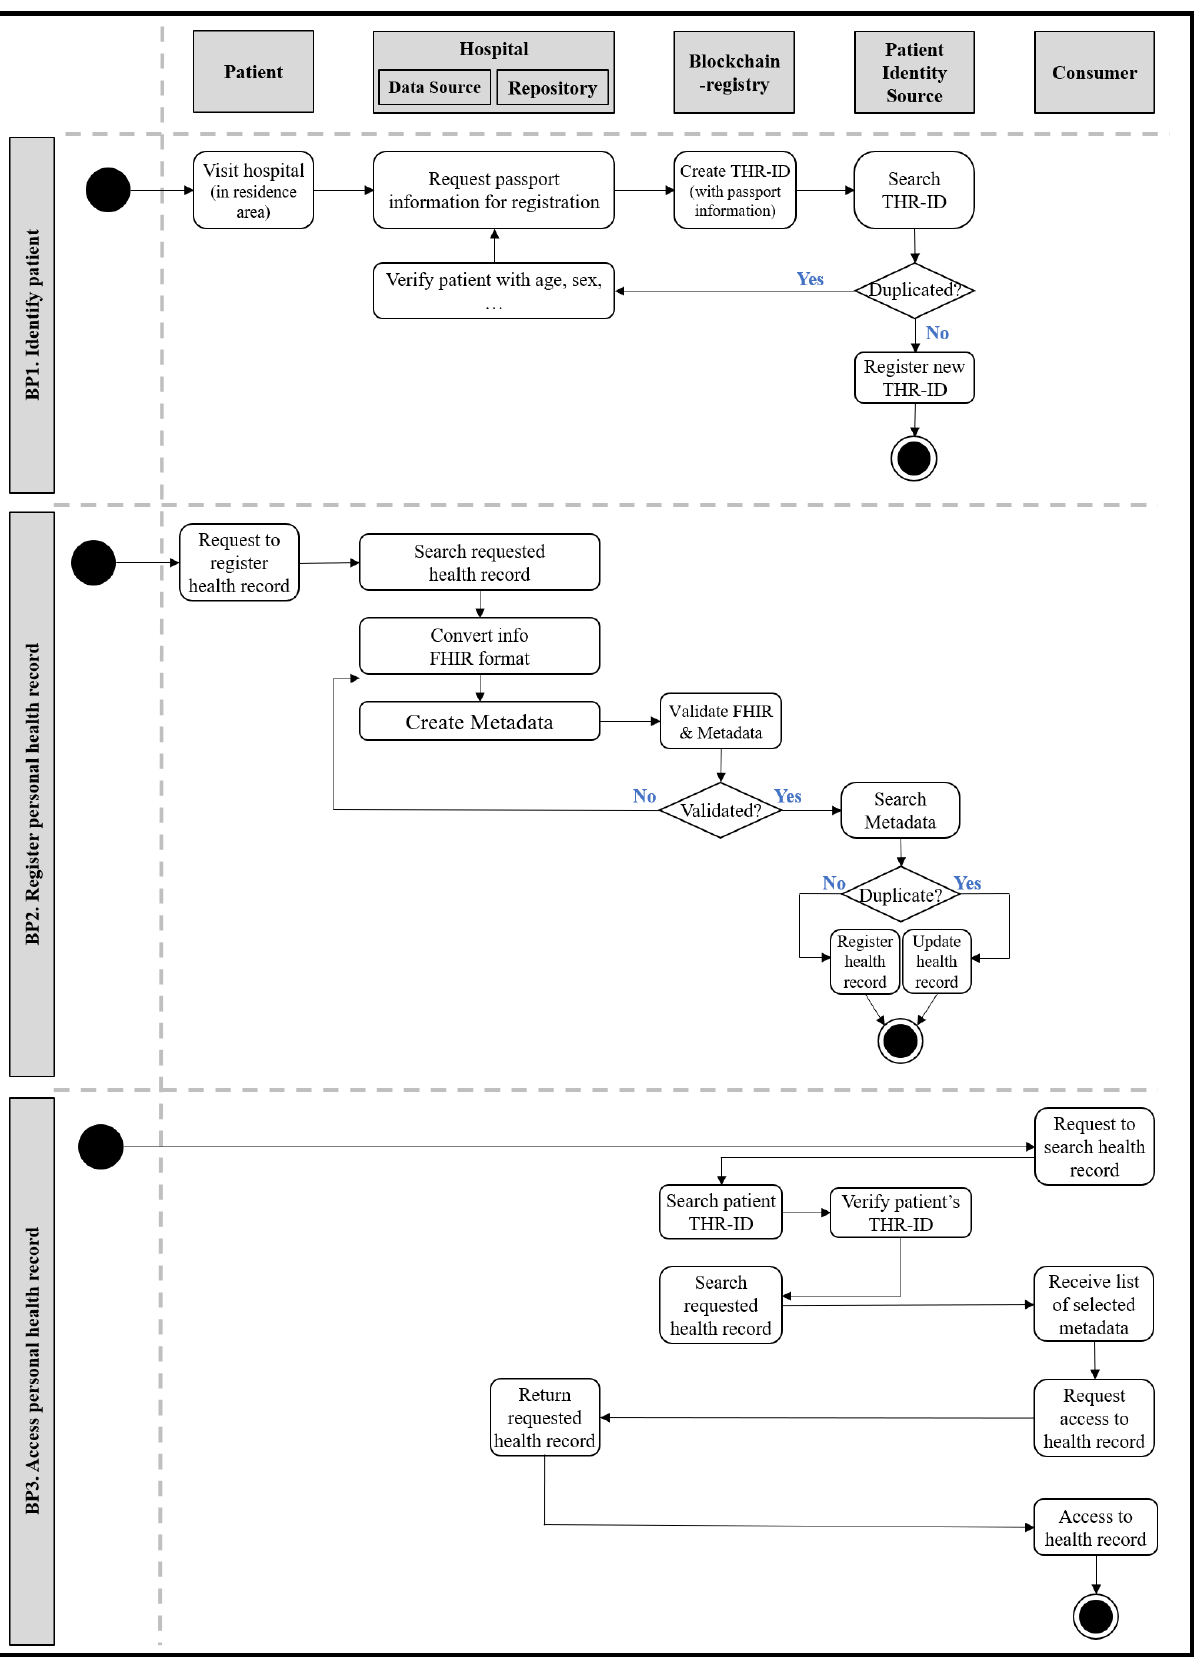
Figure 4. Workflows for business processes in the THR